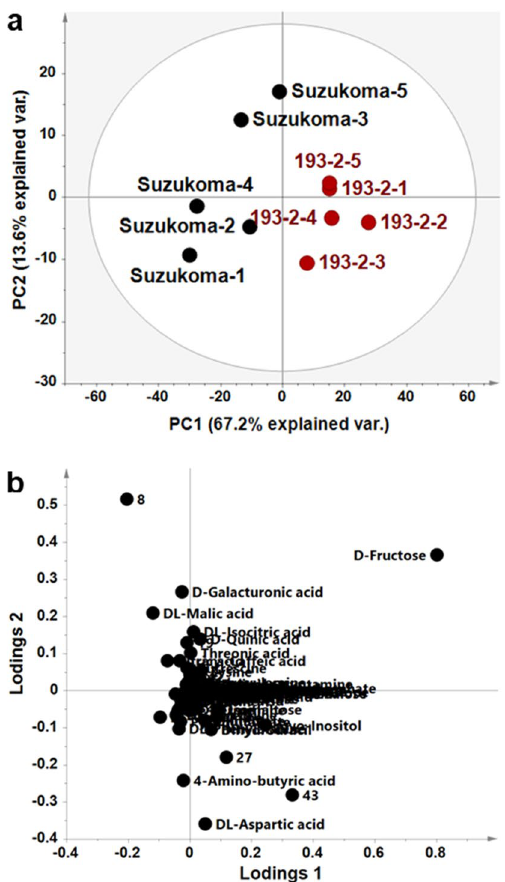
Figure 6. Principal component analysis (PCA) of metabolites in mature fruits from the SlINVINH1 genome edited line. Metabolite levels in mature fruits obtained from original cultivar ‘Suzukoma’ and the SlINVINH1 genome edited line (193–3) were determined by GC-TOF/MS. ( a ) Score scatter plot of the PCA. Black symbol indicates ‘Suzukoma’ and red symbol indicate the SlINVINH1 genome edited lines ( n = 5 for each sample). ( b ) Loading scatter plot of the PCA analysis ( n = 148 metabolite peaks). Numbers indicate unknown peak of